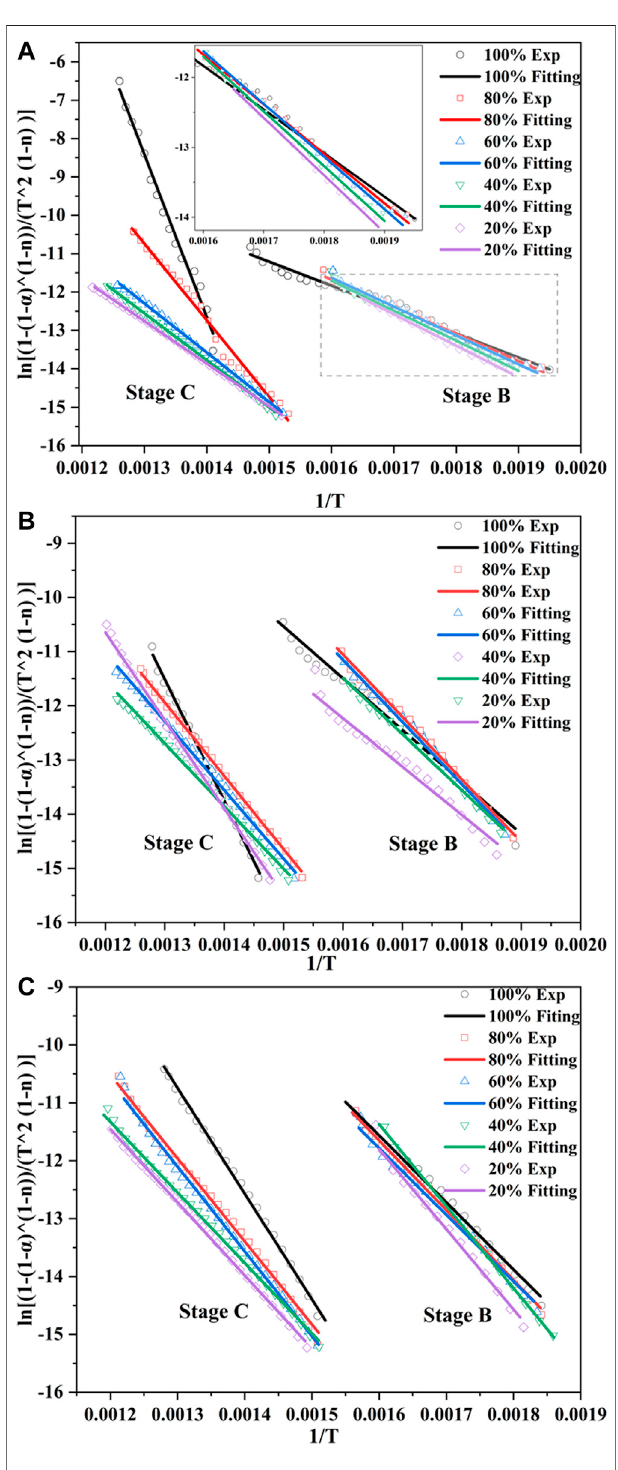
FIGURE 7 | CR plots for coal/biomass blends: (A) CS, (B) RS, and (C) RH.